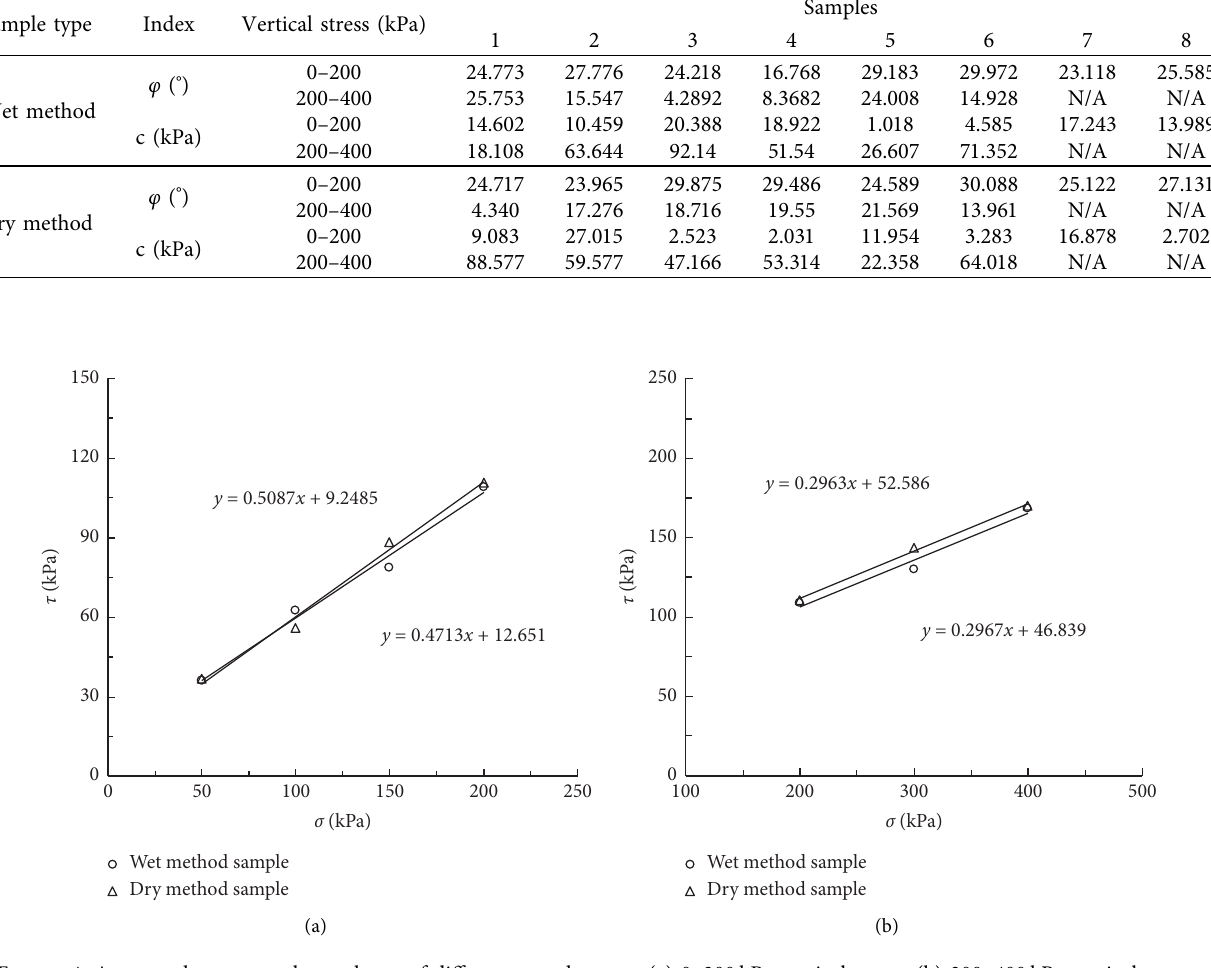
Figure 4: Average shear strength envelopes of different sample types. (a) 0–200kPa vertical stress; (b) 200–400kPa vertical stress. Table 7: c and φ values of the average shear strength